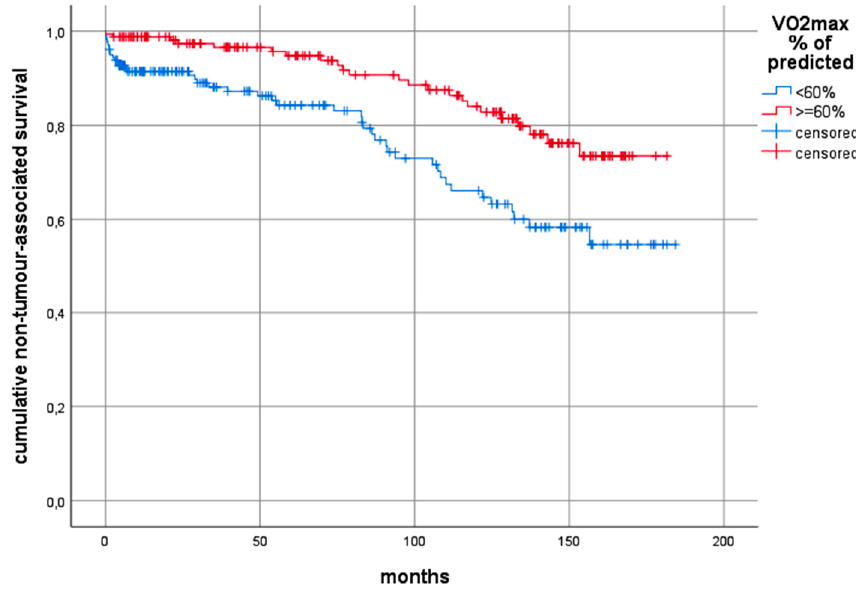
Figure 3. Kaplan–Meier curves comparing the non-tumour-related 10-year survival between those patients with predicted VO 2 peak >= 60% and those with predicted VO 2 peak < 60%. Log-rank test: chi 2 = 10.78, p = 0.001. Abbreviations: VO 2 peak: preoperative peak oxygen consumption. Peak oxygen consumption (VO 2 peak of predicted) correlated positively with predicted FEV 1 , and negatively with ASA (ASA-Physical status; American Society of Anaesthesiologists) and, remarkably,